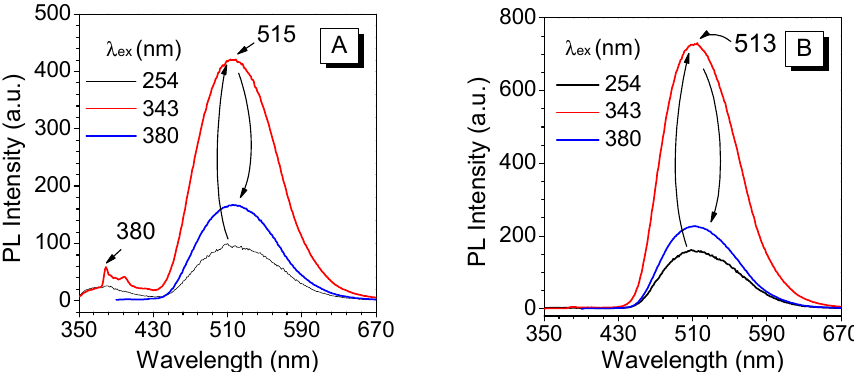
Figure 6. PL spectra of P 1 ( A ) and P 3 ( B ) in solution excited at di ff erent wavelengths: 254 nm (black), 343 nm (red) and 380 nm (blue). Solvent: THF, concentration: 0.02 mmol /